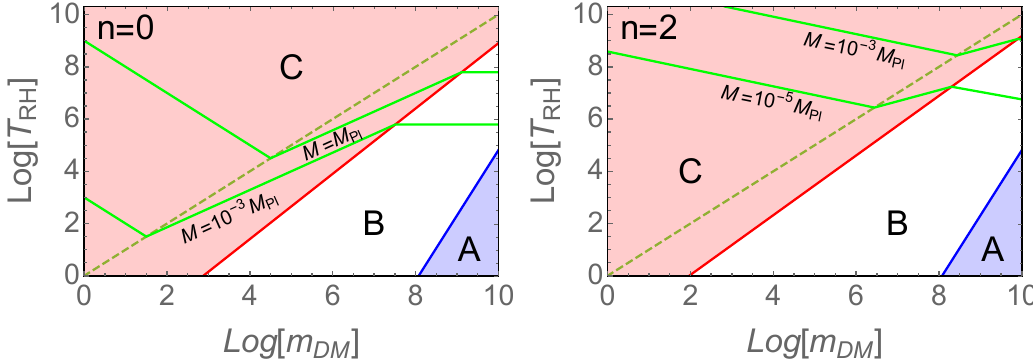
Figure 2 . Dominant contribution for the production of DM during the reheating epoch in T RH − m DM space. The blue, white, red regions represent parameter spaces that the contribution A, B, and C is dominant, respectively. We set n = 0 (left panel) or n = 2 (right panel). Each green line represents parameters where we can explain the observed amount of DM with M being the value = m shown in the figure. The dashed line represents T RH DM